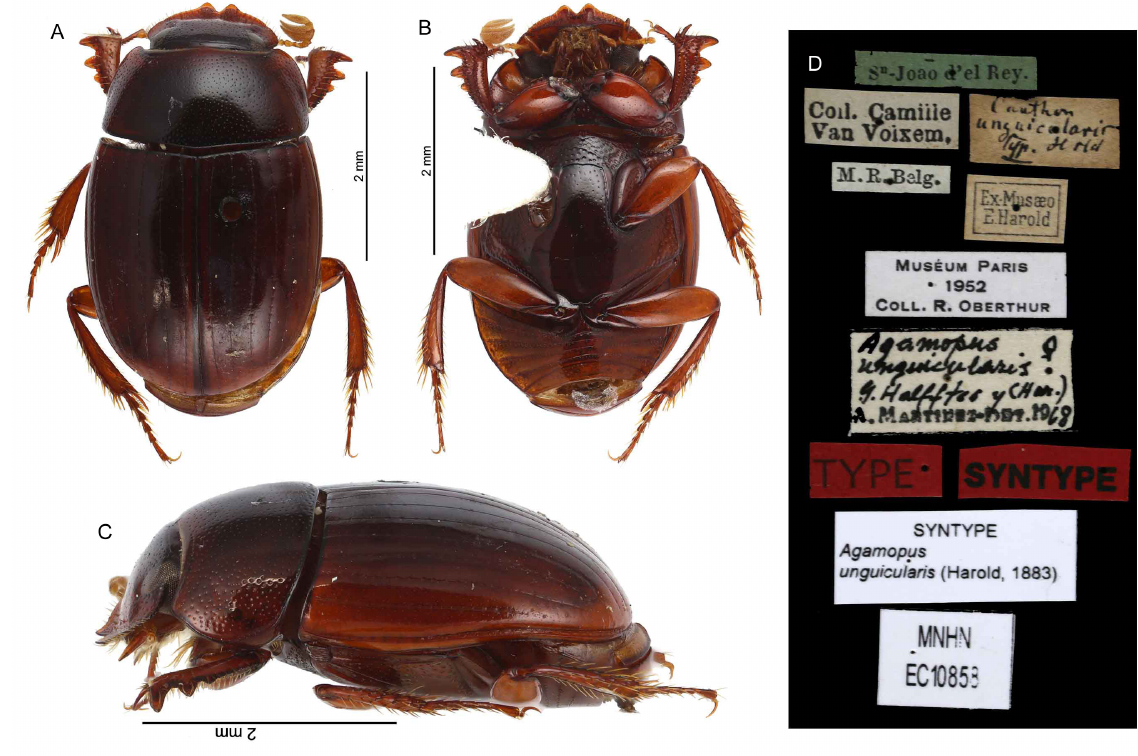
Fig. 8. Canthon unguicularis Harold, 1883 [now Agamopus unguicularis ]. Lectotype, ♀ (MNHN). A . Habitus, dorsal view. B . Habitus, ventral view. C . Habitus, lateral view. D . Labels. Photographs: Christophe Rivier,